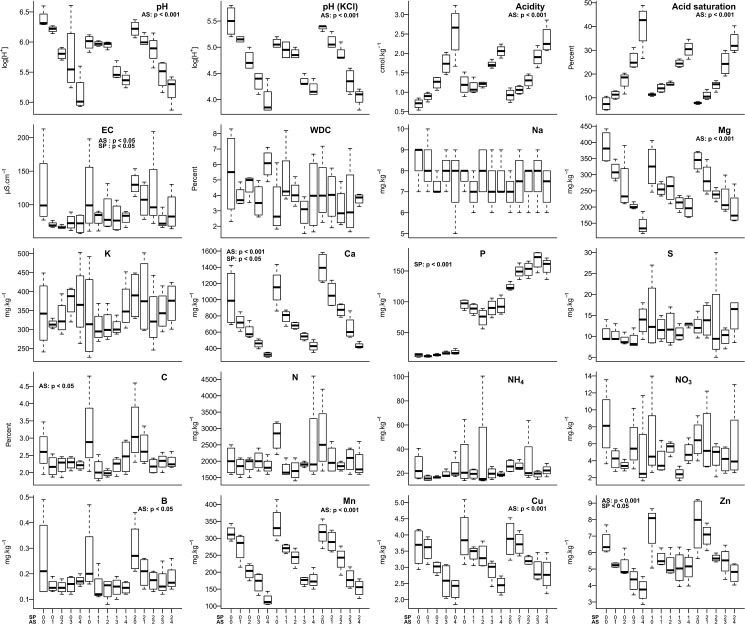
Concentrations of soil properties according to experimental treatment at Towoomba in 2014.Box-plots show medians (dark bar), upper and lower quartiles (tops and bottoms of boxes), and ranges (upper and lower whiskers). AS = ammonium sulphate; SP = superphosphate. p values show the results of the Kruskal-Wallis testing for individual effects of AS and SP after Friedman testing for differences across all treatments.